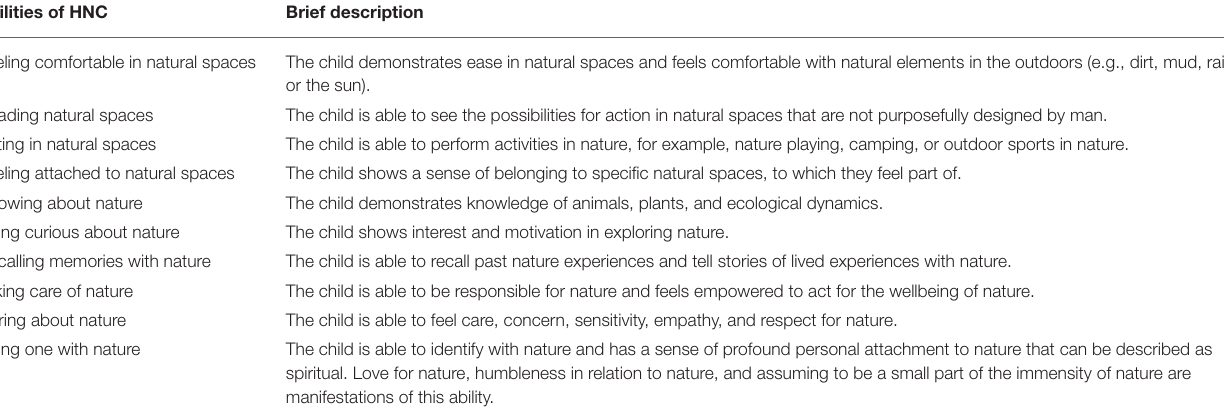
TABLE 2 | List of abilities of human-nature connection with the associated brief